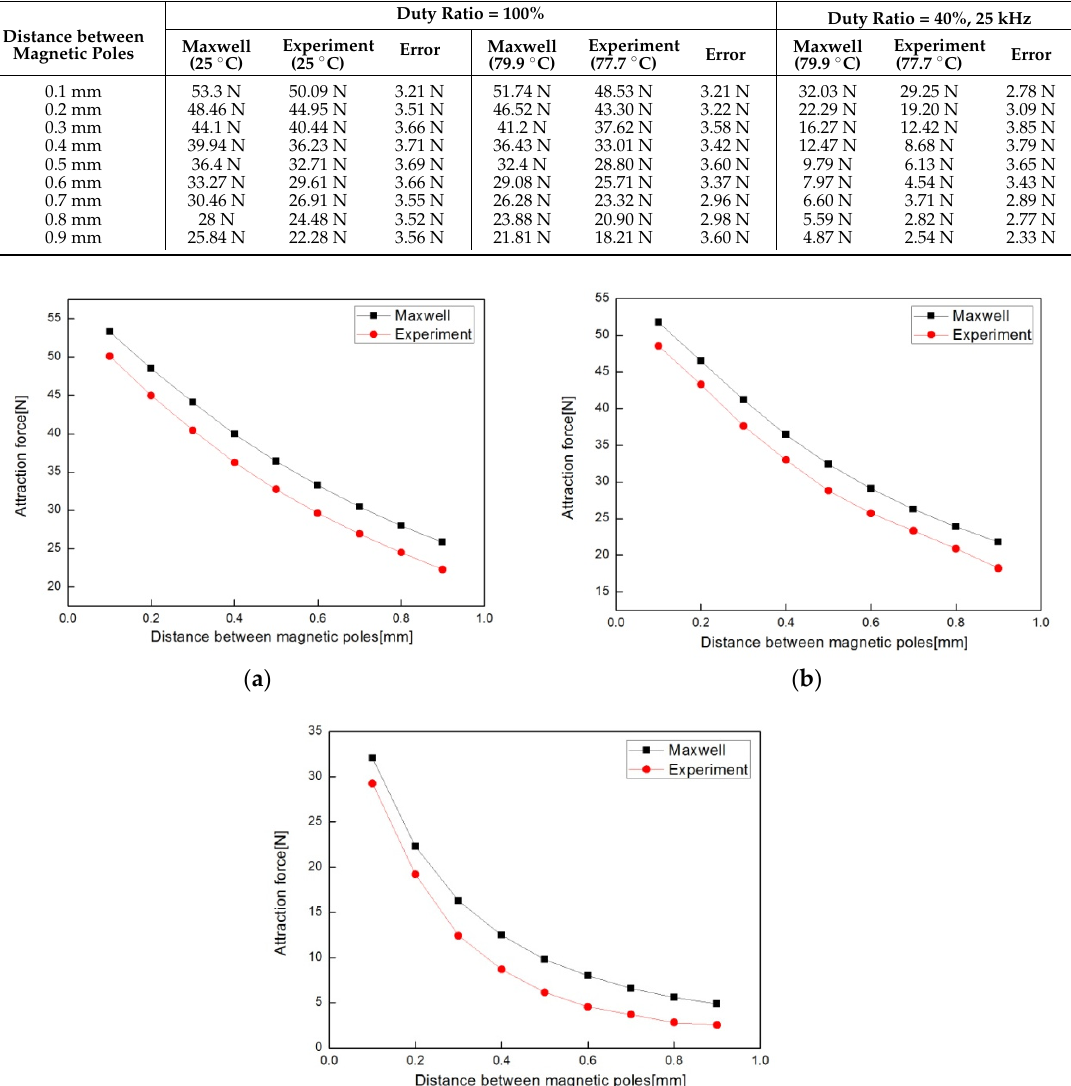
Table 5. Attraction force with respects to distance between magnetic poles and duty ratio. Distance between Magnetic Poles